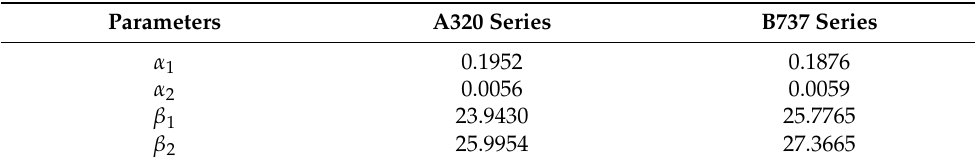
Table 1. Prior parameters for domestic mainstream aircraft in terms of the evolution of the ground handling process for different aircraft